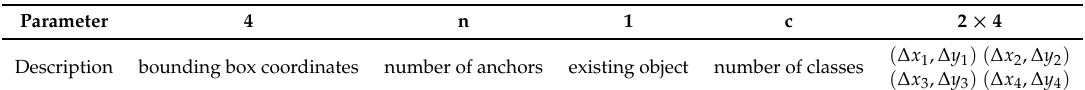
Table 2. The meaning of the parameters of the output.